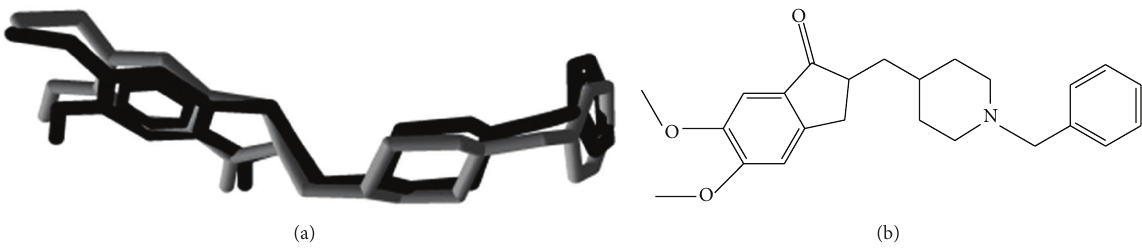
Figure 1: (a) Superposition between cocrystallized (black) and predicted (gray) donepezil. (b) Molecular structure of donepezil. Table 2: Interaction energies between inhibitors and AChE.